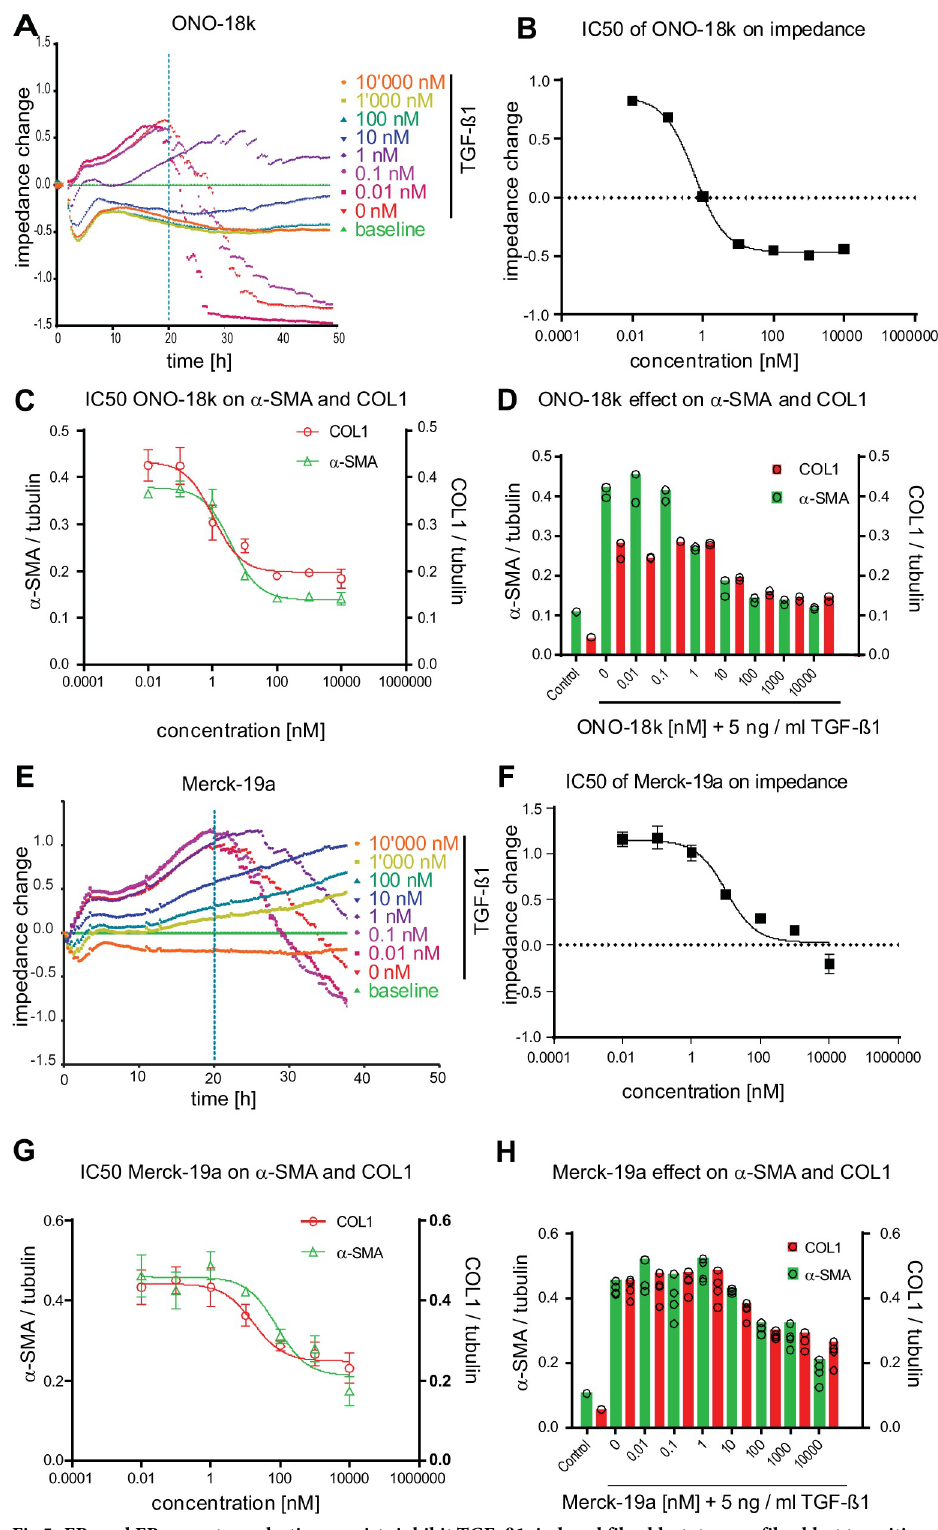
Fig 5. EP 2 and EP 4 receptor–selective agonists inhibit TGF– β 1–induced fibroblast–to–myofibroblast transition of NHLF. NHLF cells were incubated with dilution series (0.01–10,000 nM) of the G α s–biased EP 2 receptor agonist ONO–18k (–A) or the EP 4 –receptor selective agonist Merck–19a (E) and then stimulated with 5 ng / ml TGF– β